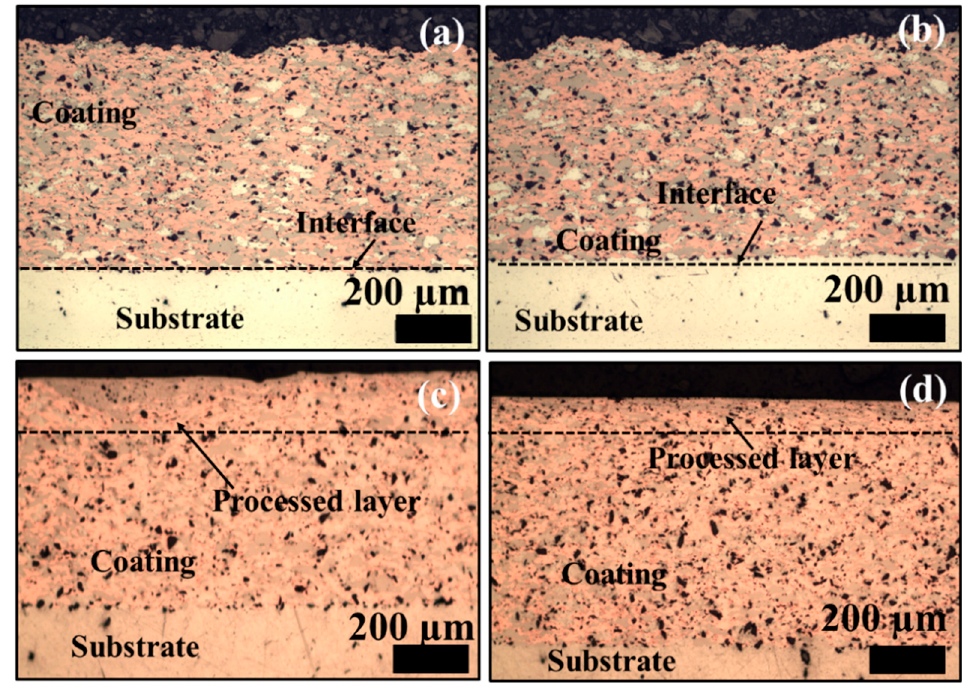
Figure 3. Optical micrographs of the cross ‐ sectional cold sprayed coatings ( a ) S1, ( b ) S2, ( c ) FSP ‐ S1, and ( d ) FSP ‐ S2.